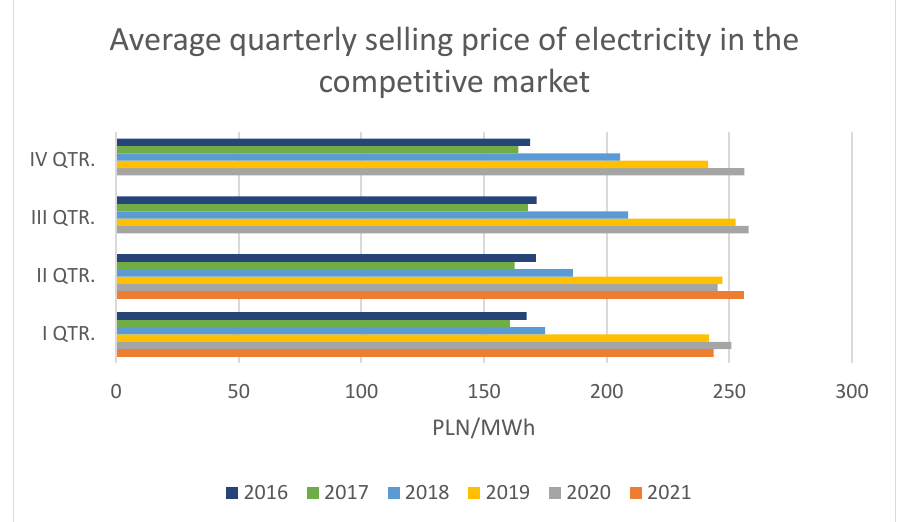
Figure 2. Average quarterly selling price of electricity in the competitive market. Source: author’s own compilation based on collective quarterly information from the President of the URE on the selling price of electricity in the competitive market.